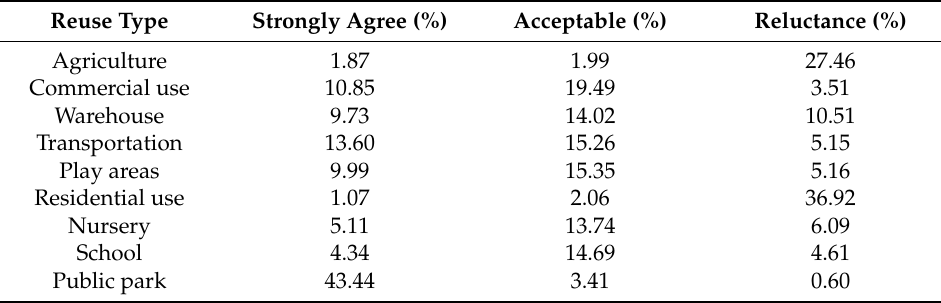
Table 5. Public acceptance of alternative reuse